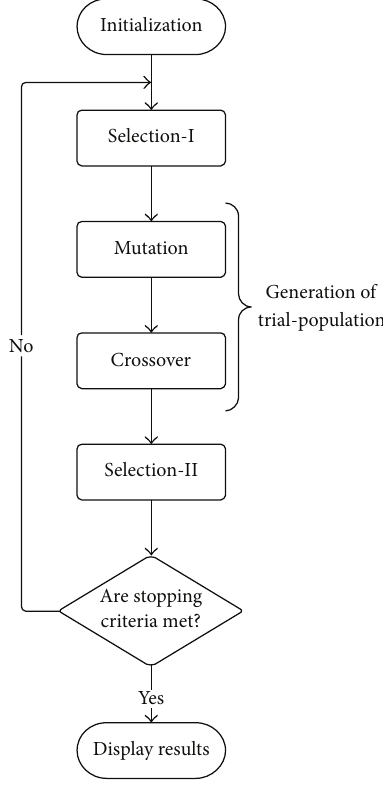
Figure 2: General flowchart of BSA.